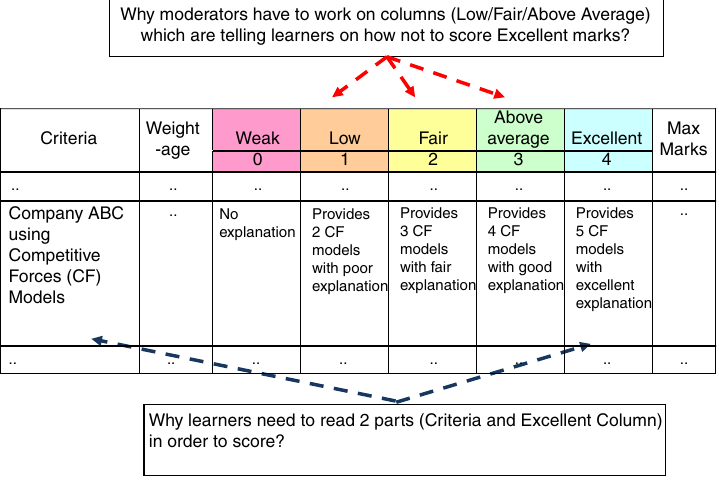
Figure 5. Various LoPs referred in assignment